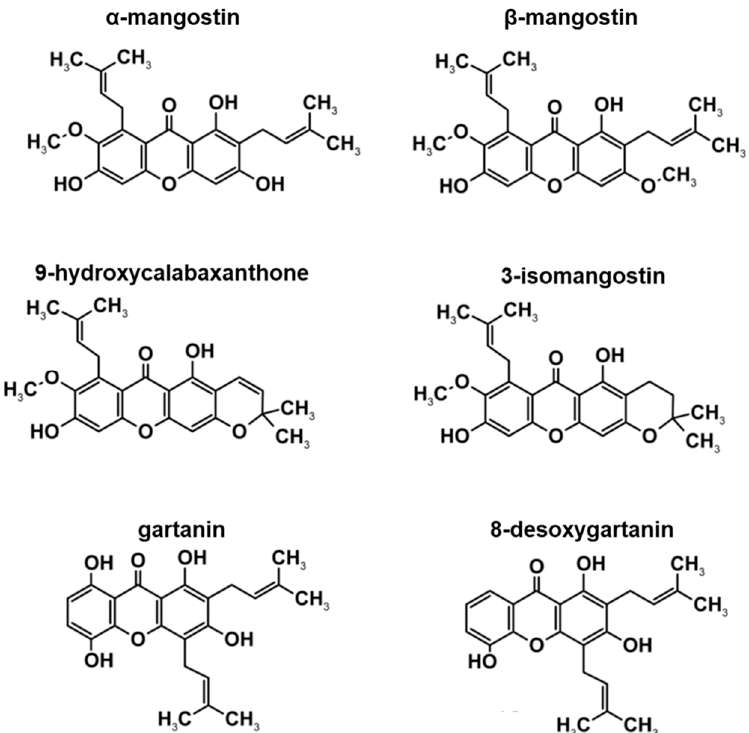
Figure 2. Chemical structures of α -mangostin ( α -MG), β -mangostin ( β -MG), 9-hydroxycalabaxanthone, 3-isomangostin, gartanin, and 8-desoxygartanin, which are reportedly present in XCE [21]. Figure is adapted from Walker [28] with permission from Elsevier (Copyright 2007).